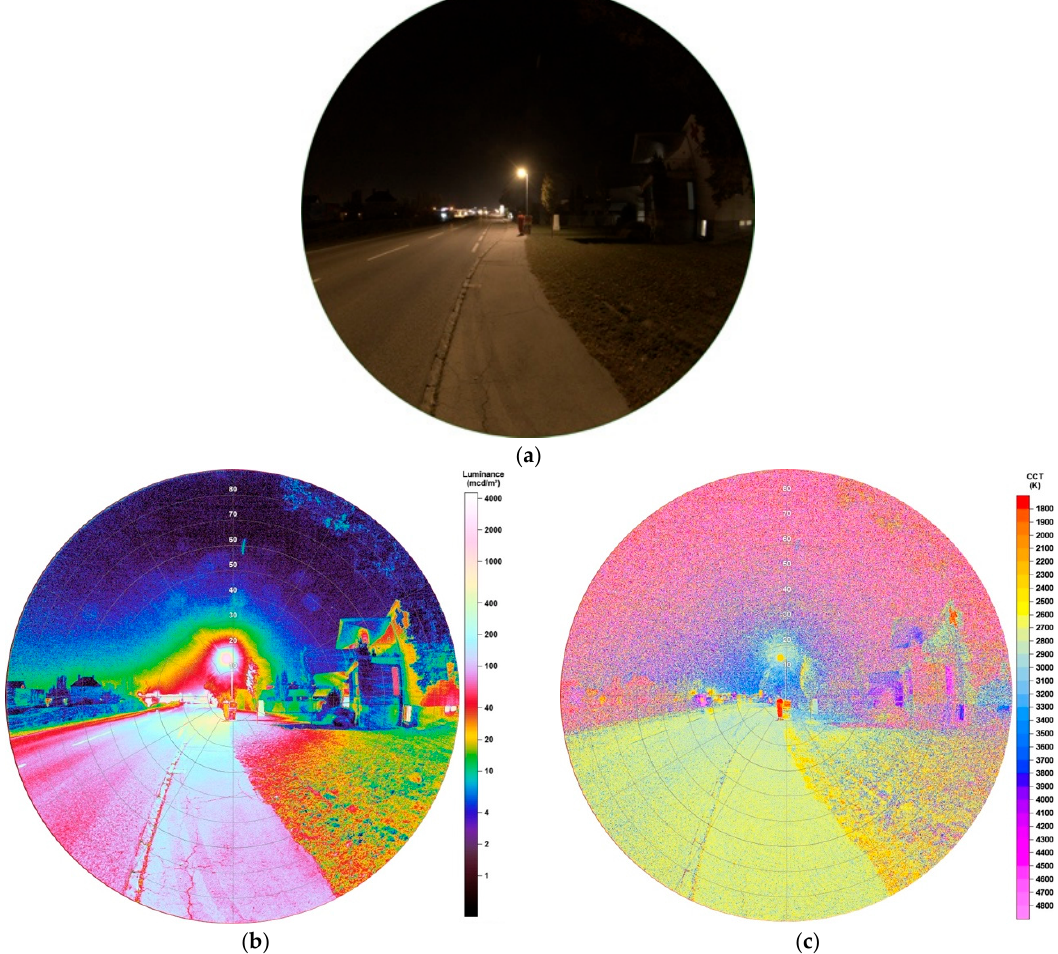
Figure 4. ( a ) Image of LED lamp during night-time taken with fisheye lens for detailed analysis (date: 10.10.2018, 22:57 h; exposure time: 0.6 s); ( b ) Luminance matrix of image (a) as displayed by SQC; ( c ) CCT matrix of image (a) as displayed by SQC.